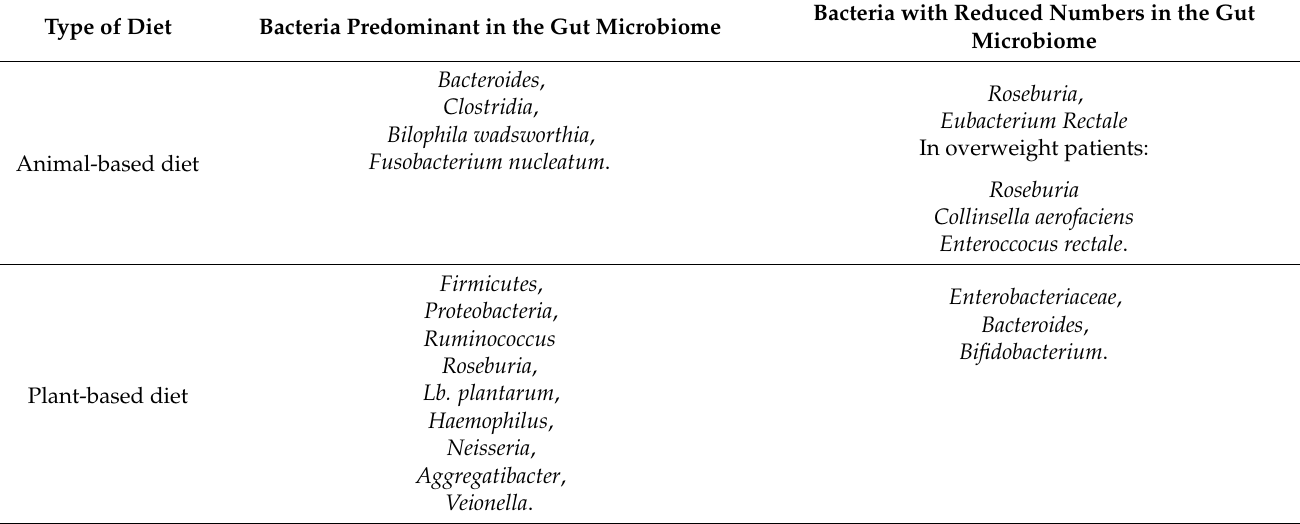
Table 1. The influence of animal- and plant-based diet on the composition of gut microbiota [41–43,50,54,56,57]. Type of Diet Bacteria Predominant in the Gut